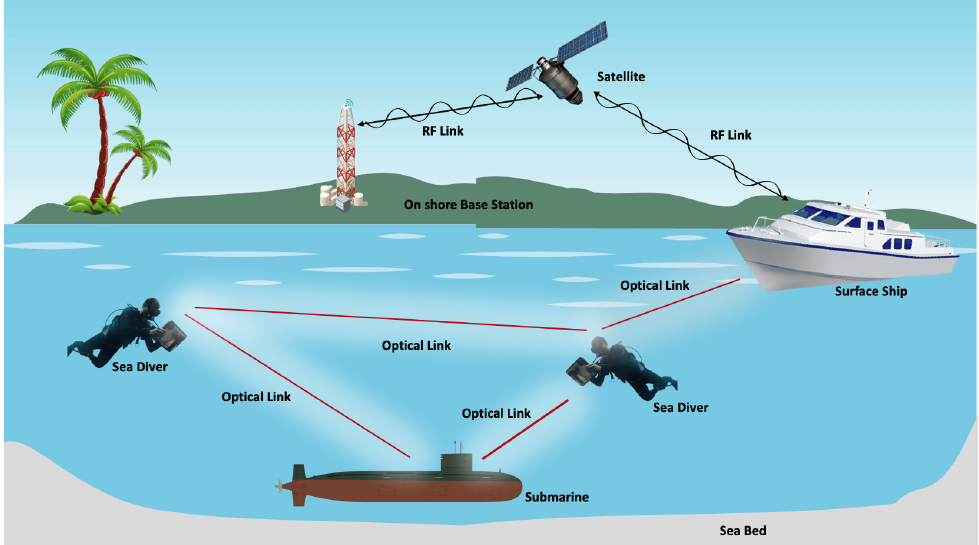
Figure 1. Line of sight optical wireless communications for